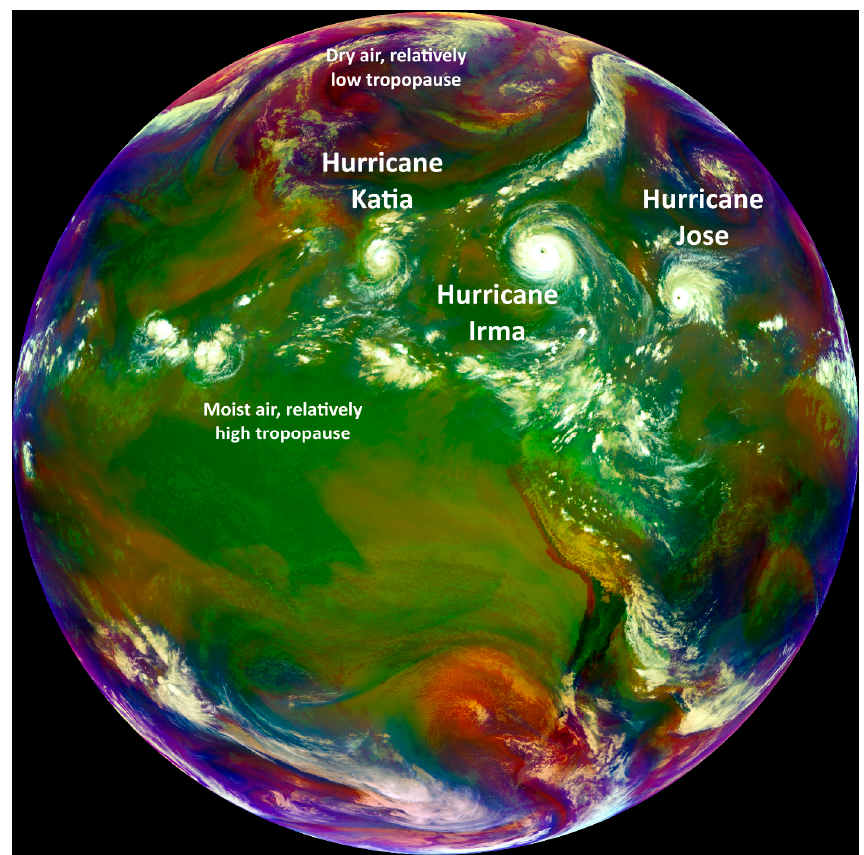
Figure 18. Airmass RGB from GOES-16 from 8 September 2017 at 1745 UTC. This product is created by applying 6.2–7.3 μ m, 9.6–10.3 μ m, and 6.2 μ m band differences/bands to the red, green, and blue components, respectively. Remote Sens. 2018 , 10 , x FOR PEER REVIEW